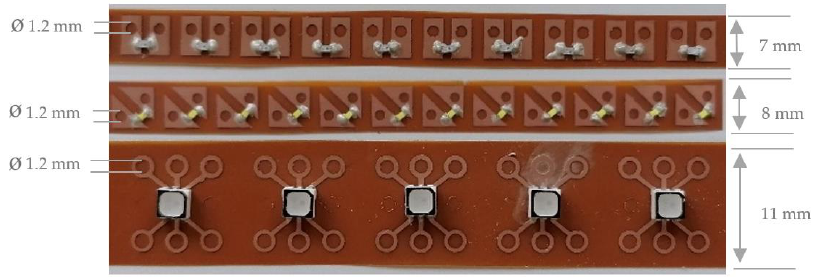
Figure 9. Printed single-layer LED and RGB sequin tapes on copper-clad film. The sequin tapes are very flexible and the electronic components and the copper surface are stable against bending and twisting (Figure 10).